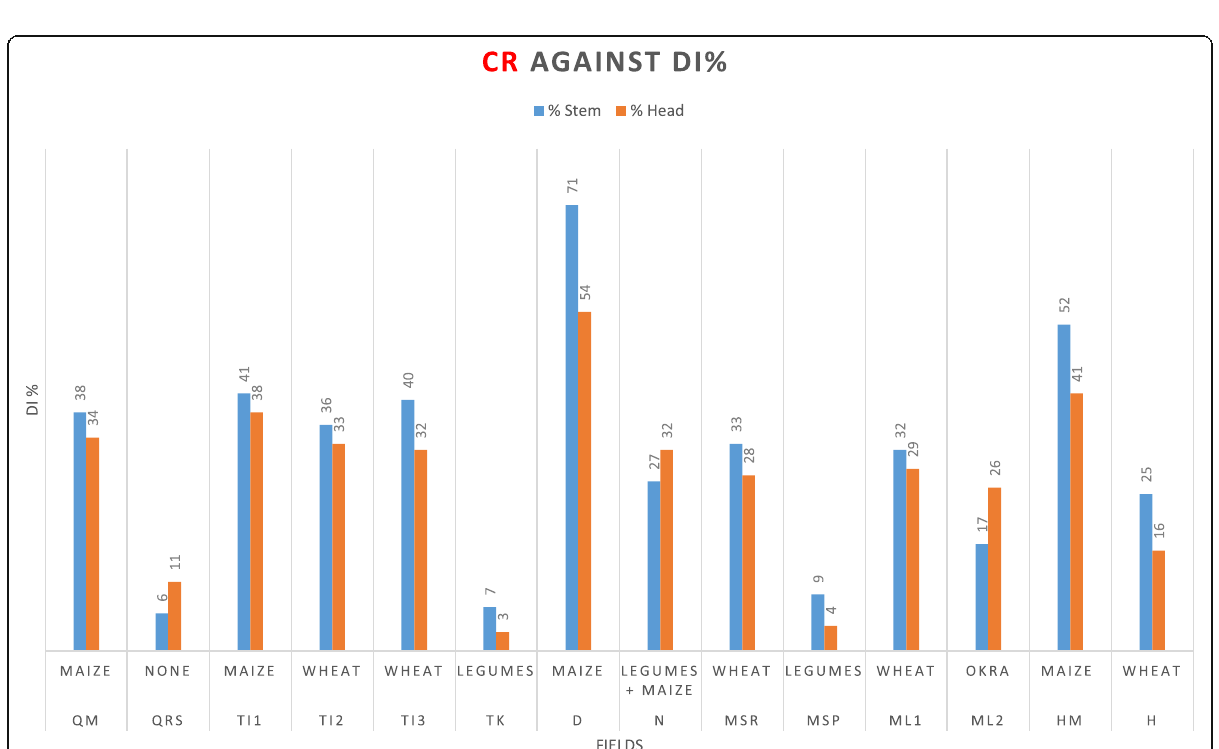
Fig. 4 The effect of crop rotation on disease incidence in plant head and stem in the 14 selected wheat fields in the south of Iraq/Basra province